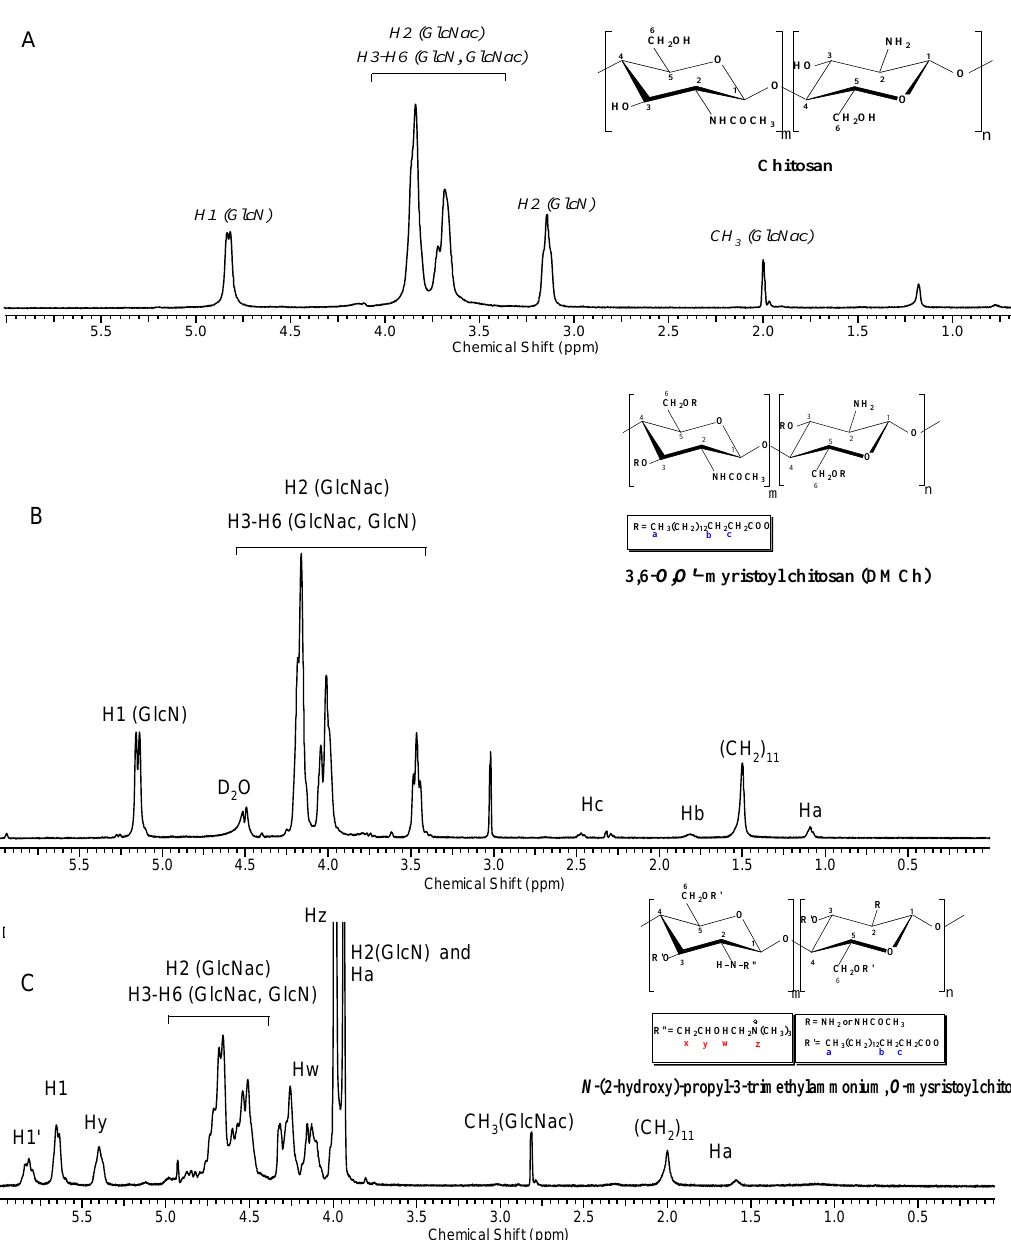
Figure 2. ( A ) 1 H nuclear magnetic resonance (NMR) spectra of chitosan, ( B ) DMCh, and ( C ) DMCat in solution D 2 O/HCl 1% ( v / v ) acquired at 80 °C.